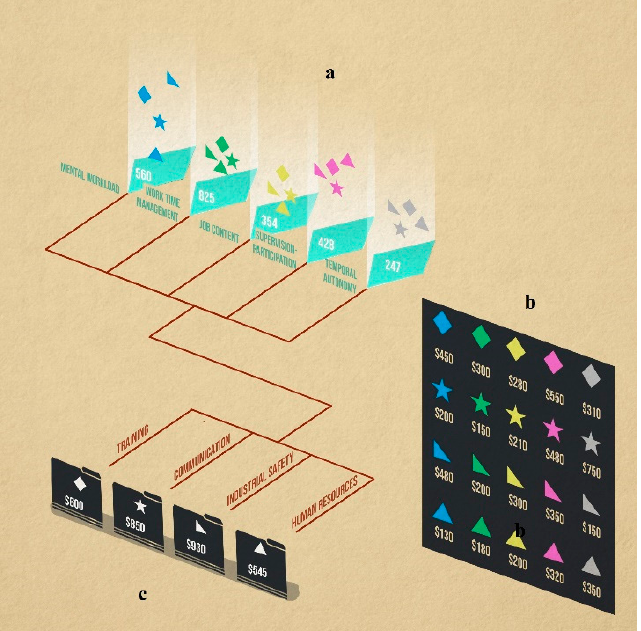
Figure 4. MKP mapping scheme: ( a ) The PSRs with a specific risk level represented by a color; ( b ) The department cost matrix for each color risk; ( c ) The departments attending the selected risks with a limited budget.